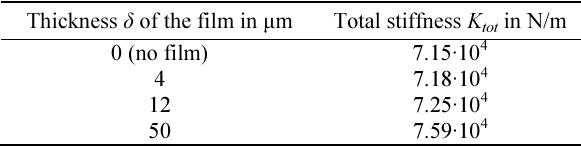
Table 2. Total normal stiffness of the system of two particles with average particle size,